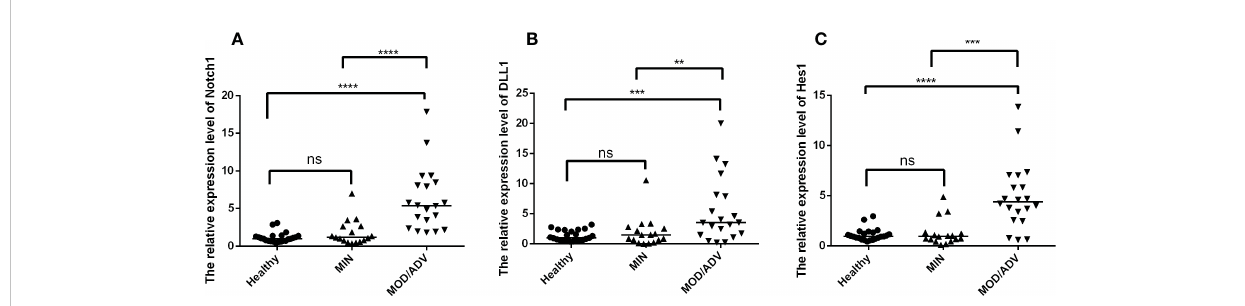
FIGURE 2 Comparison of the mRNA expression of Notch1, DLL1 and Hes1 in healthy individuals ( n =23) and active TB patients with mild (n=17) or moderate/ severe (n=20) disease were compared by using Kruskal-Wallis one-way analysis of variance by ranks. The standardization of data were used the housekeeping gene b -actin and shown as the mean ± SD of three times experiments. (A – C) presented the mRNA expression of Notch1, DLL1, and Hes1 in healthy controls and patients with different degrees of disease, respectively. ** p < 0.01, *** p < 0.001, **** p < 0.0001, ns , not signi fi